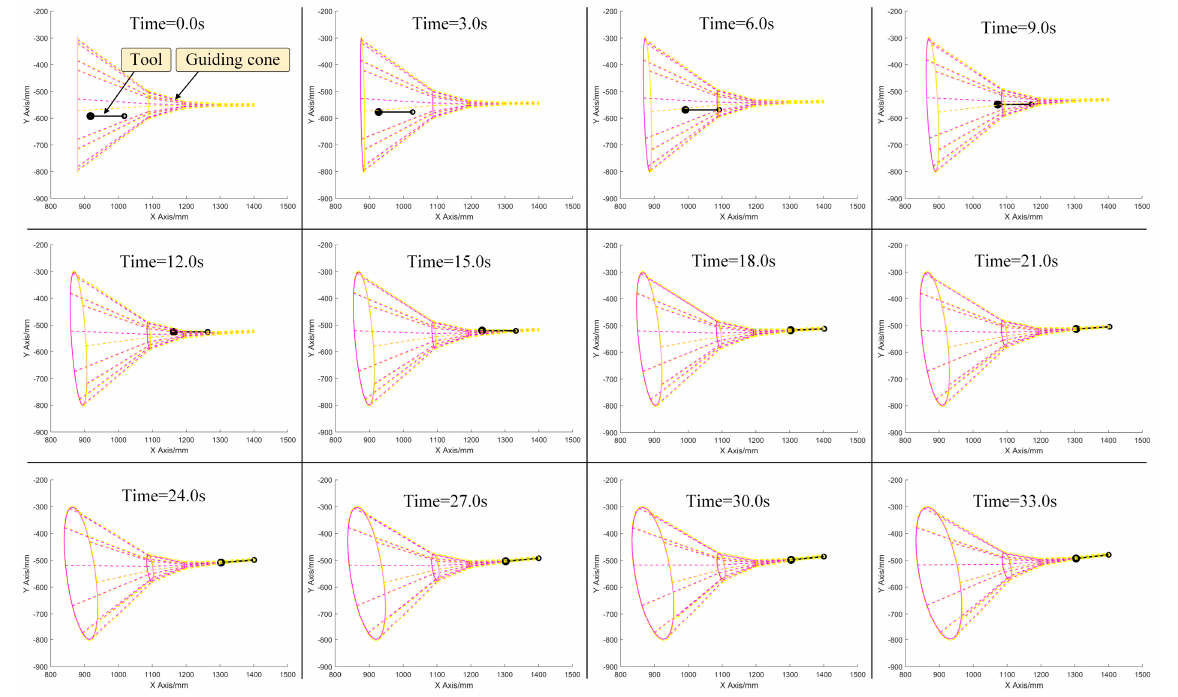
Figure 16. Simulation of “dynamic and manual” feeding. Despite the guiding cone moving, the tool can still track and hit the dynamic target successfully. Additionally, the result of simulation on “dynamic and automatic” feeding is just the same.